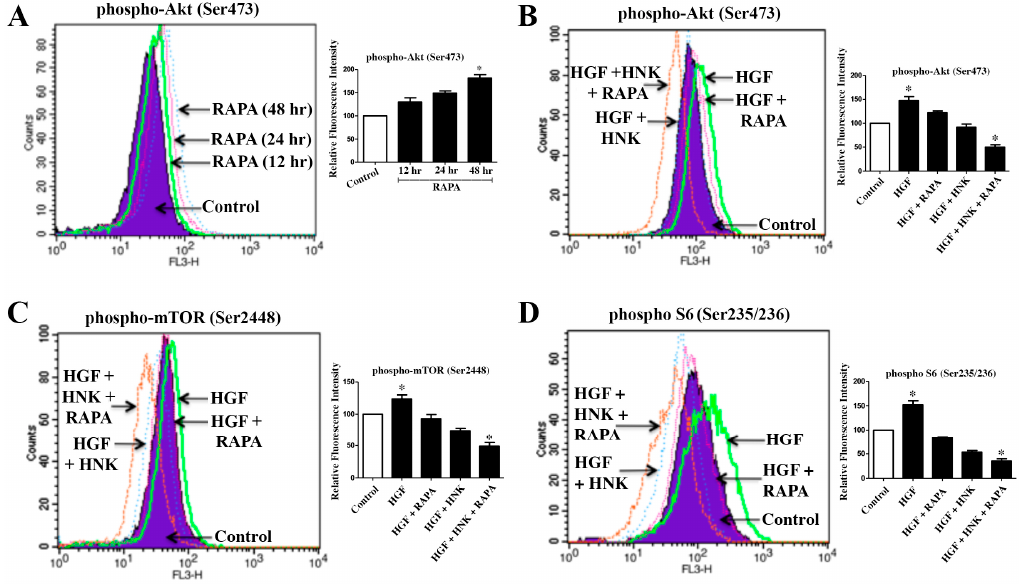
Figure 1. Rapamycin (RAPA) + Honokiol (HNK) combination downregulates HGF-induced phosphorylation of Akt, mTOR and S6 in renal cancer cells. ( A ) The 786-0 cells were treated with either RAPA (15 µ M) or vehicle for 12–48 h. Following treatment, intracellular phospho-Akt (Ser473) expression (in permeabilized cells) was analyzed by flow cytometry. ( B – D ) Serum starved 786-0 cells were pre-treated with combinations of RAPA (15 µ M) and HNK (40 µ M) for 4 h, and then incubated with either HGF (50 ng / mL) or vehicle alone for 1 h. Following treatment, cells were analyzed for the intracellular levels of phospho-Akt (Ser473), phospho-mTOR (Ser2448) and phospho-S6 (Ser235 / 236) by flow cytometry. ( A – D ), representative data of three independent experiments; and the bar graphs presented next to histogram overlays represent the quantification of changes in relative fluorescence intensities compared with the control (control values were considered as 100%). The columns represent the mean ± S.D. of duplicate experimental readings. * p < 0.05 compared with respective